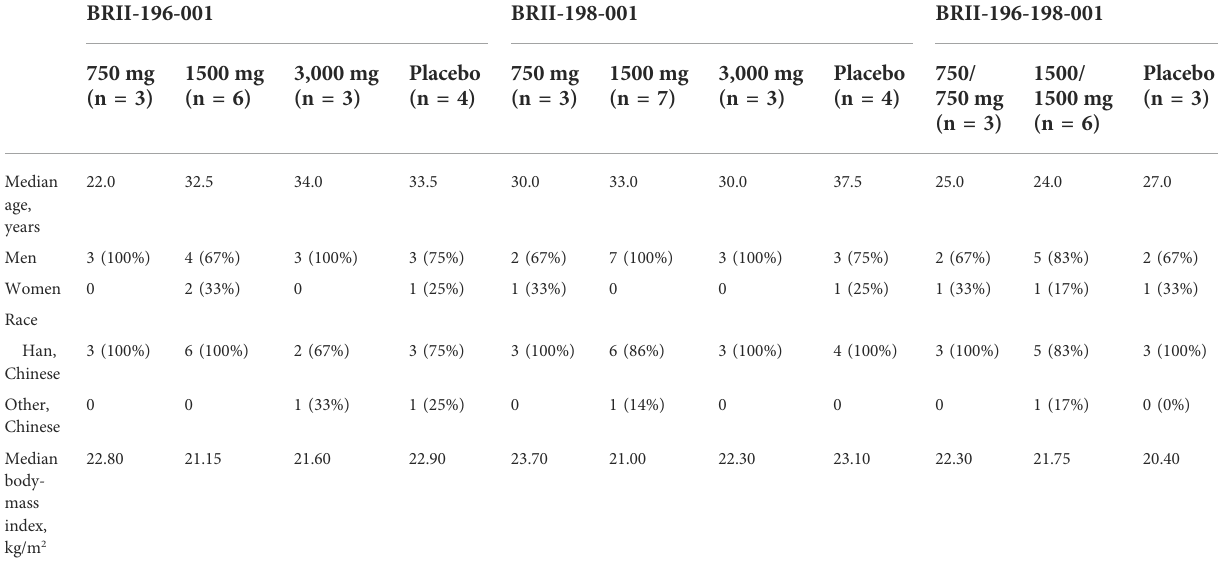
TABLE 1 Participant demographics and baseline